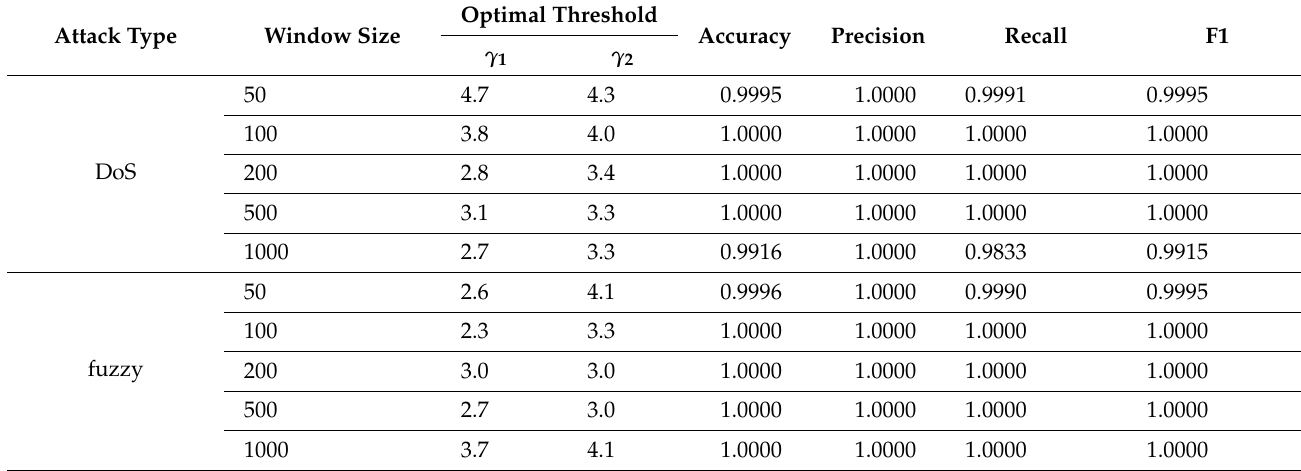
Table 16. Performance parameters for